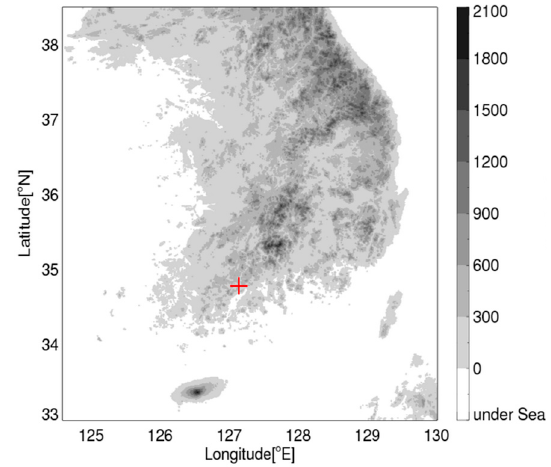
Figure 1. Location of the Boseong Standard Weather Observatory (BSWO) site (red cross), Deungryang-myeon, Boseong-gun in which the cloud radar is installed.